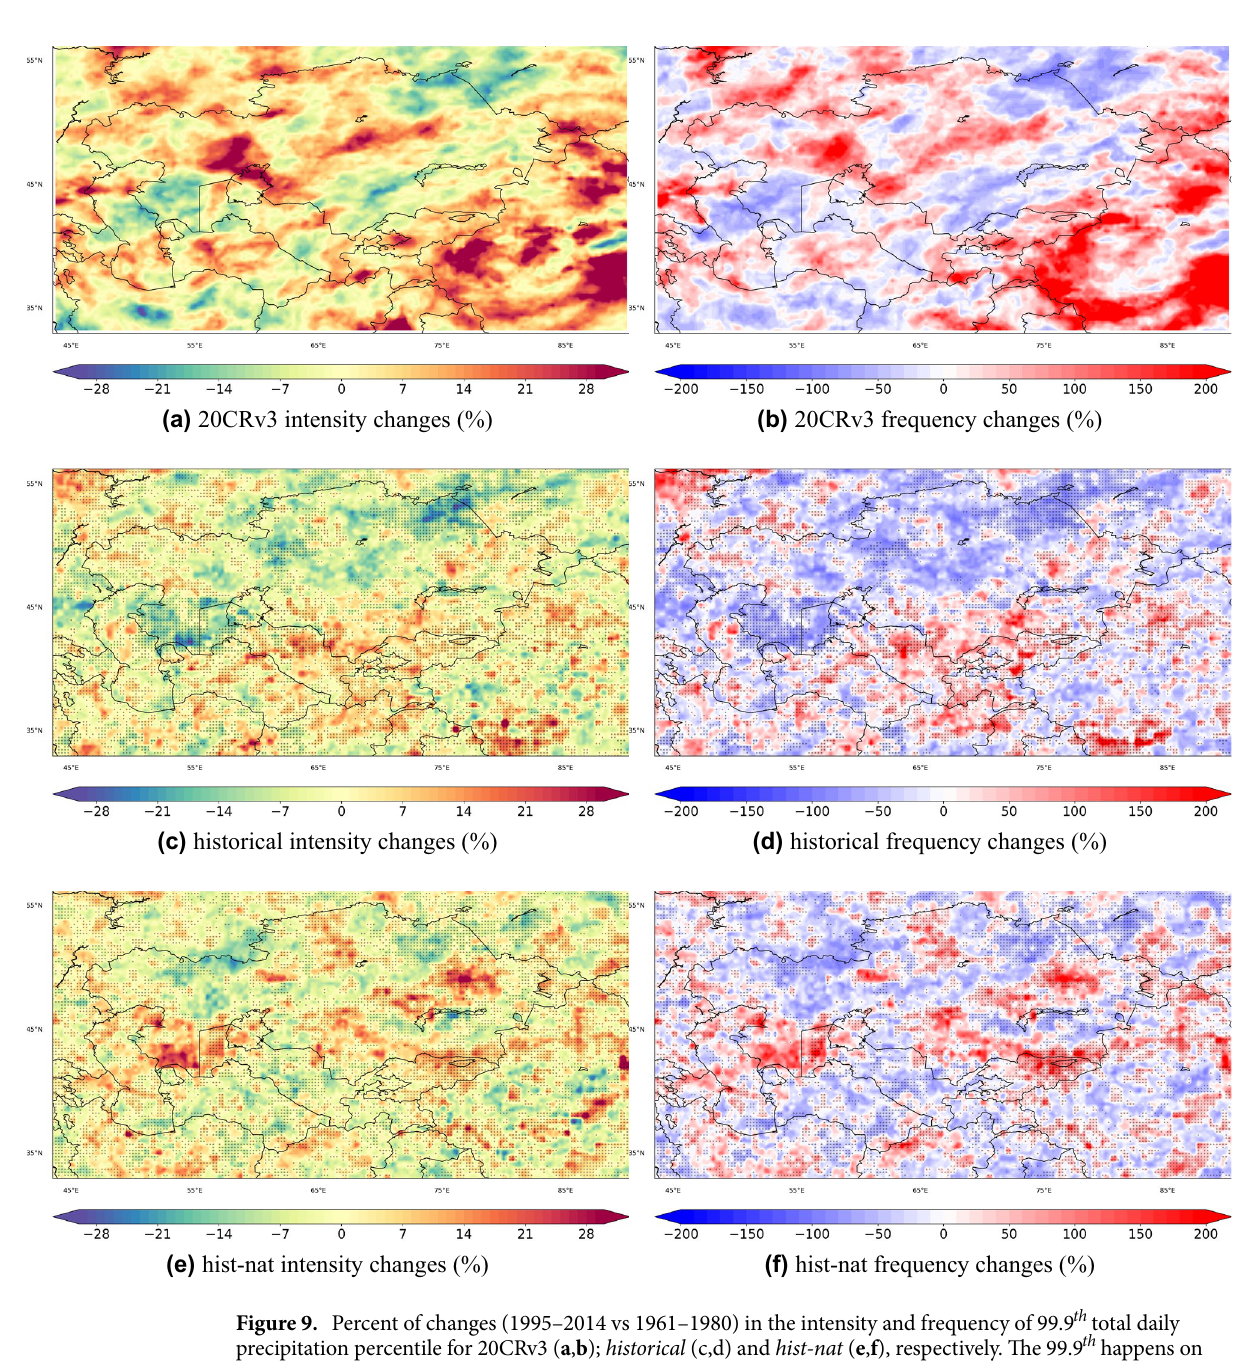
Figure 9. Percent of changes (1995–2014 vs 1961–1980) in the intensity and frequency of 99.9 precipitation percentile for 20CRv3 ( a , b ); historical (c,d) and hist-nat ( e , f ), respectively. The 99.9 average once in 1300 days in the 20CRv3 data. Black dots indicate the agreement in the signs with 20CRv3. The maps were created using python3-matplotlib (version 3.1.2, https:// matpl otlib.